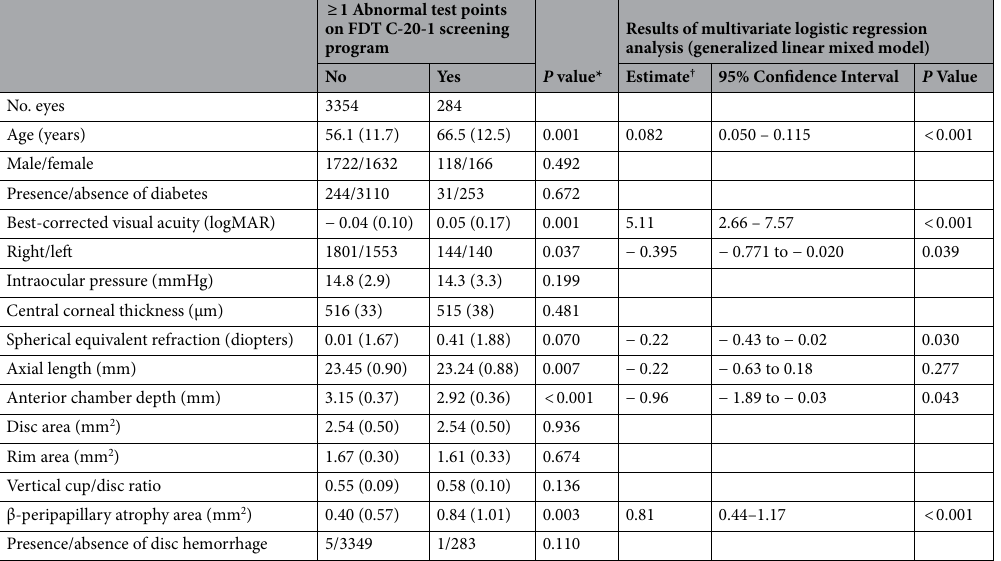
Table 2. Results of univariate and multivariate logistic regression analysis in 3638 normal eyes of 2255 normal subjects for whom all parameter values for analysis were available. The data are expressed as the mean (standard deviation). logMAR logarithm of the minimum angle of resolution, FDT frequency-doubling technology. *Univariate logistic regression analysis (generalized linear mixed model). † Positive values of estimates indicate false-positive or abnormal responses to the FDT screening test in normal